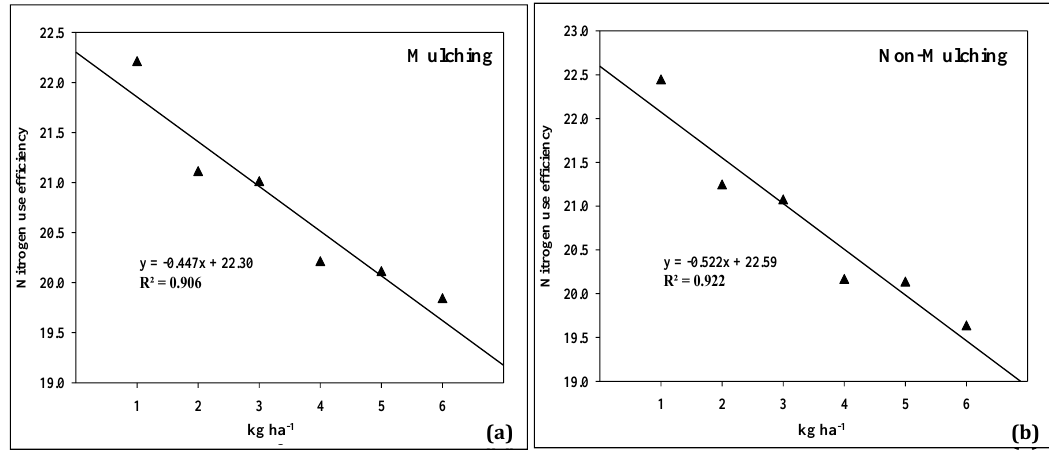
Figure 8. Relationship between nitrogen application rates and Rh inoculation (1 = 50% RDN (12.5 kg ha − 1 ); 2 = 50% RDN (12.5 kg ha − 1 ) + Rh ; 3 = 75% RDN (18.75 kg ha − 1 ); 4 = 75% RDN (18.75 kg ha − 1 ) + Rh ; 5 = 100% RDN (25 kg ha − 1 ); 6 = 100 % RDN (25 kg ha − 1 ) + Rh ) and nitrogen use efficiency in peanut under mulched ( a ) and nonmulched ( b ) treatments in 2016–2017.